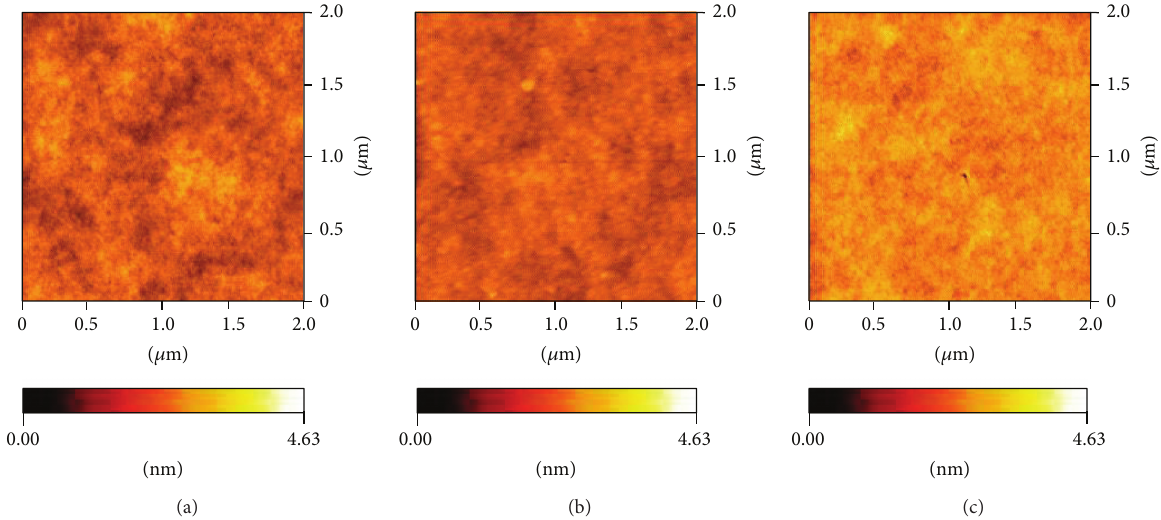
Figure 6: AFM images of the PC 71 BM thin films: (a) prepared with pristine CB, (b) prepared with CB and additive of DIO (3v%), and (c) prepared with CB and additive of CN